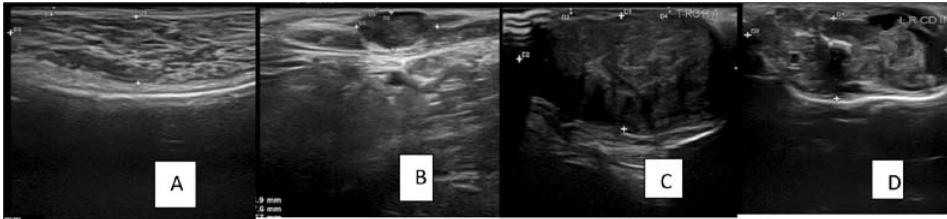
Fig. 1 . Sonographic images of mammary gland depicting echotexture. (a) Normal healthy mammary gland. (B) Homogenous echotexture of a benign mammary neoplasm. (c) Heterogenous echotexture of a benign